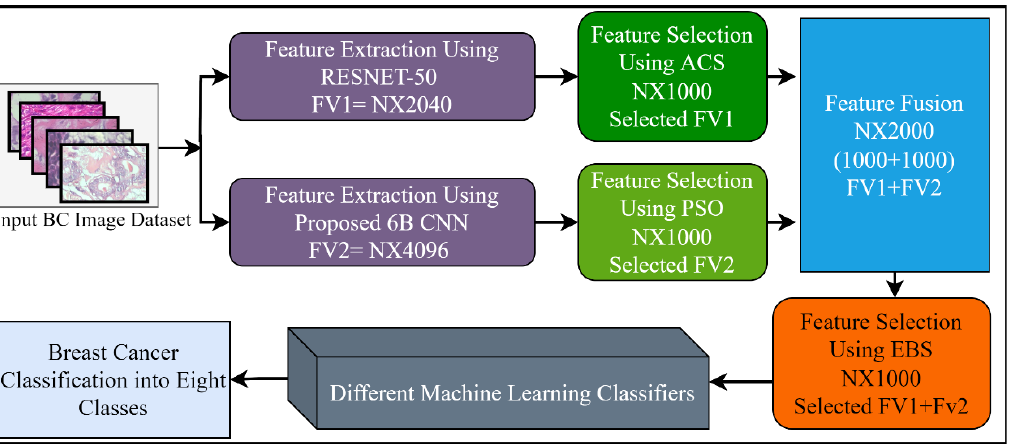
Figure 3. The proposed feature selection and fusion strategy with details of the number of fea-